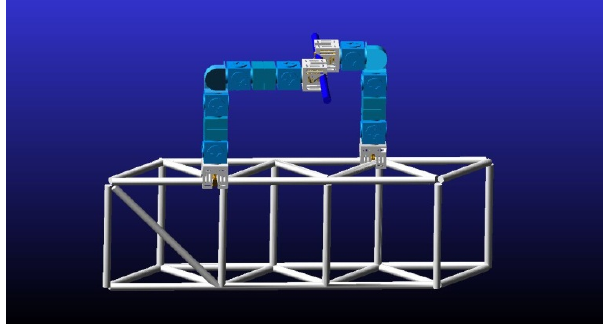
Figure 17. Simplified model of robot truss assembly.